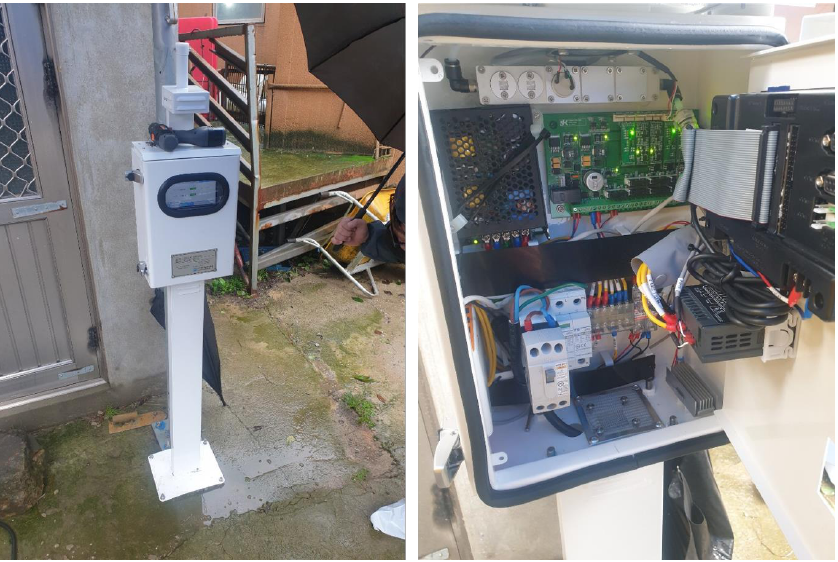
Figure 2. The outside and inside of livestock odor management system. The sensor case (outside) must protect the inside, and the inside is composed of a measurement sensor, modules, communi- cation equipment, and power terminal.